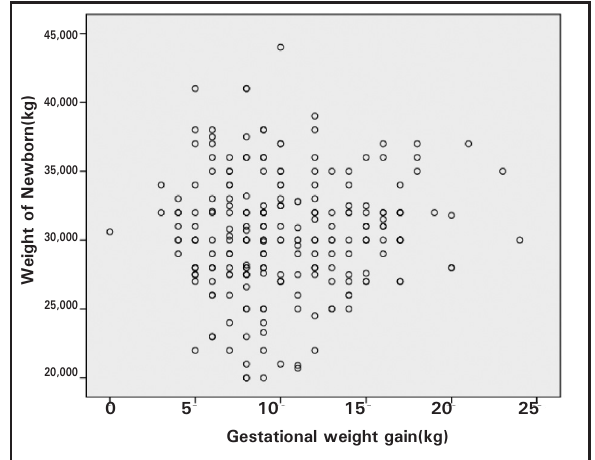
Figure 1. Relationship between gestational weight gain and birth weight of the newborn.